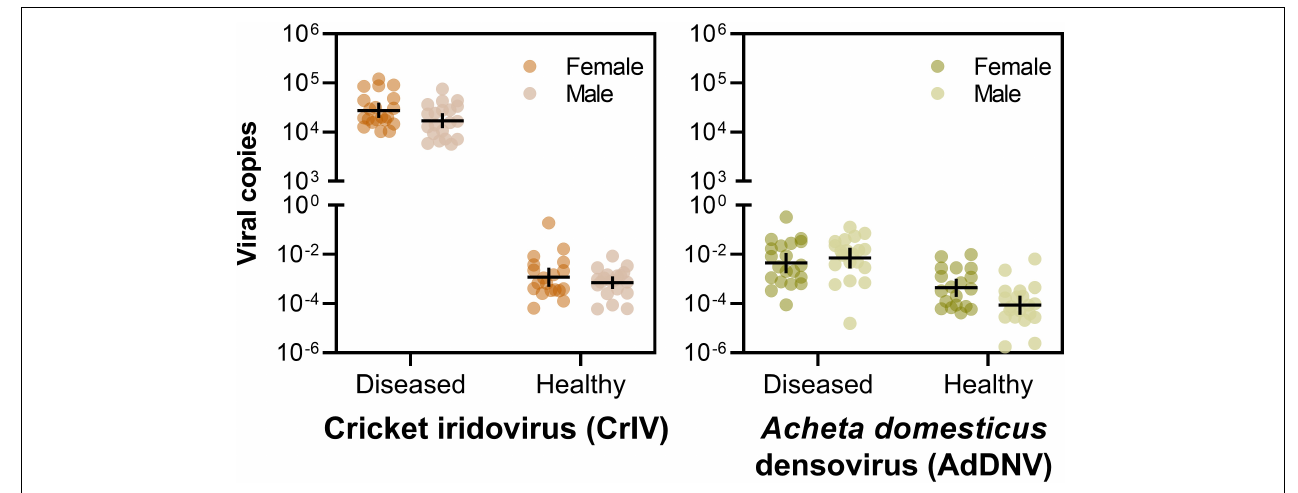
FIGURE 2 | Viral loads of cricket iridovirus (CrIV) (left) and Acheta domesticus densovirus (AdDNV) (right) detected across two populations (“Diseased” and “Healthy”) of male and female adult reared Gryllodes sigillatus (geometric mean ± 95% confidence intervals). The graphs depict the ratio of viral copies normalized to cricket tubu3 copies, shown on a log scale. Post hoc comparisons are indicated on Table 4